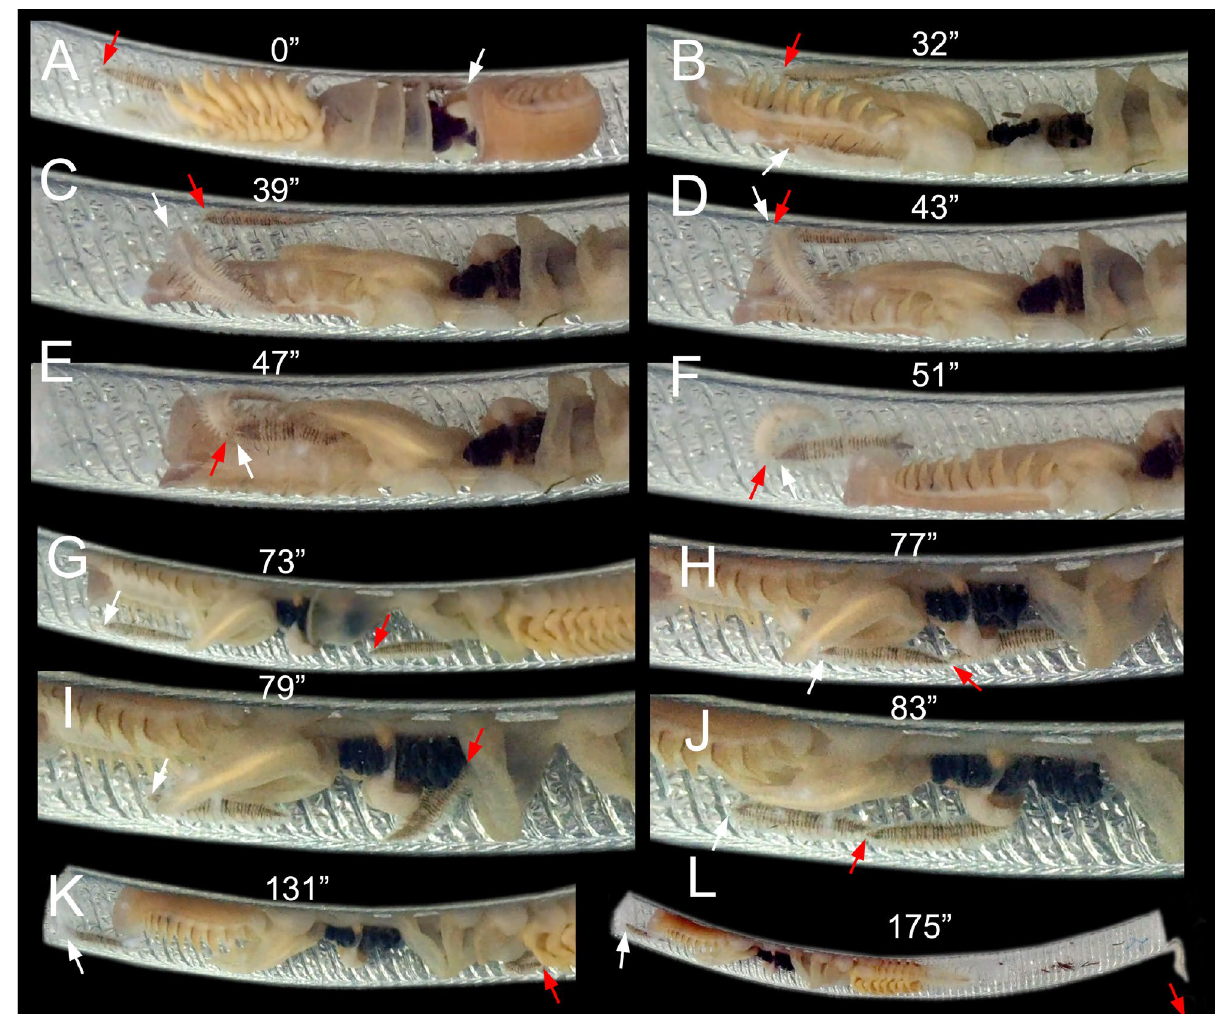
Figure 4. Sequence of a resident Ophthalmonoe pettiboneae attacking an intruder; see Supplementary material S6. The intruder is always in the same position on the inner tube wall, except after the attack. ( A ) Resident in its typical position, host starting to reverse its body. ( B ) Resident hidden behind host body, host fully reversed. ( C ) Resident closely approaching the intruder’s anterior end. ( D ) Resident starting the attack. ( E ) Resident curling with the intruder during the attack, host slowly retracting its body. ( F ) Resident still biting the intruder, both curling one over the other, host apparently giving them room to fight. ( G ) Resident near host’s anterior end, intruder around host’s mid-body. ( H ) Intruder closely approaching the resident’s posterior end. ( I ) No reaction from resident, but intruder suddenly reversing its body. ( J ) No reaction from resident, intruder again closely approaching the resident’s posterior end. ( K ) Resident slowly moving towards the inhalant siphon, intruder already oriented towards the exhalant siphon. ( L ) No reaction from resident, intruder almost already outside the tube. White arrows indicate resident’s head; red arrows indicate the intruder’s head. Time course indicated in time (Fig. 4A, Supplementary material S6). When the host started to reverse, the resident also reversed, almost immediately detected the intruder and reacted brusquely and very quickly (Fig. 4B, Supplementary material S6). The resident began advancing towards the intruder, jumping from one side of the inner tube to another and being not detected by the intruder due to the presence of the host body between them (Fig. 4C, Supplementary material S6). Perceiving the intruder from behind the host body, the resident launched a brisk attack, suddenly everting its pharynx and biting the intruder with its jaws (Fig. 4D, Supplementary material S6). Then, both worms curled one over the other for about 30–60 s (Fig. 4E–F, Supplementary material S6), ending with the resident extracting a piece of the intruder’s body. A single attack was often enough to force the intruder to abandon the host, although it took some time to leave (i.e., about 2 min; Supplementary material S6). In some instances, it even approached the resident several times (Fig. 4G–J, Supplementary material S6). Such an approach triggered either no attacks (twice) or a second attack (once) from the resident. In both cases, the intruder finally moved fast towards the exhalant tube opening and quickly exited, swimming as far as allowed by the experimental aquaria (Fig. 4K–L, Supplementary material S6). In these conditions, we never observed more than two successive attacks.